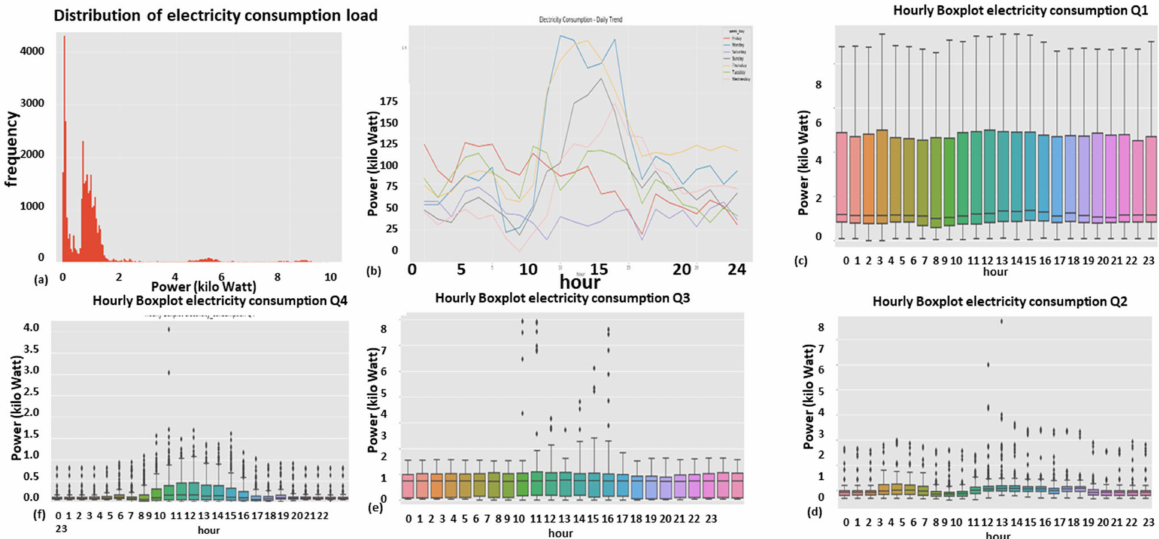
Figure 25. A characteristic of fraud examples. Left to right: ( a ) Energy distribution; ( b ) daily-hourly trends; ( c ) Q1 seasonal-hourly boxplot; ( d ) Q2 seasonal-hourly boxplot; ( e ) Q3 seasonal-hourly boxplot. ( f ) Q4 seasonal-hourly boxplot. All figures indicate